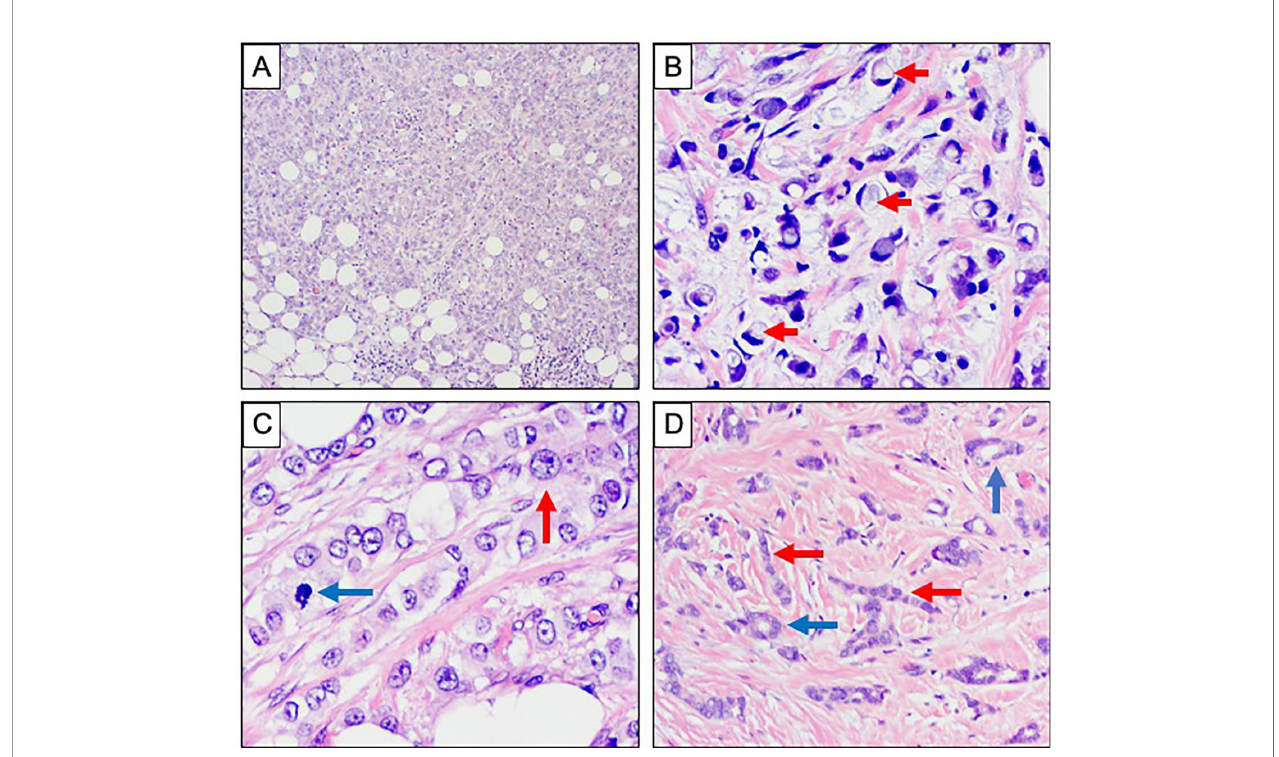
FIGURE 3 | Morphological variants of invasive lobular carcinoma. (A – D) Haematoxylin and Eosin stained sections showing morphological variants of ILC. (A) Solid growth pattern. (B) Signet ring morphology with prominent intracytoplasmic mucin vacuoles, highlighted with red arrows. (C) Pleomorphic ILC showing more prominent nuclear atypia with conspicuous nucleoli (red arrow) and mitotic activity (blue arrow). (D) Tubulolobular carcinoma showing tubule formation (blue arrows) alongside the classical single fi le pattern of invasion (red